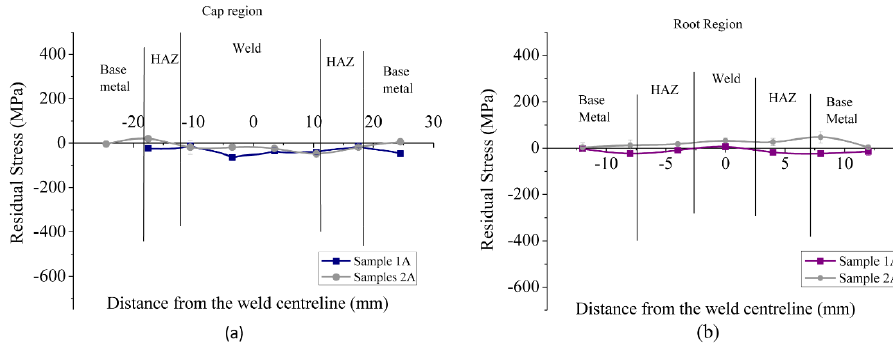
Figure 6. Residual stresses after PWHT (a) cap region and (b) root